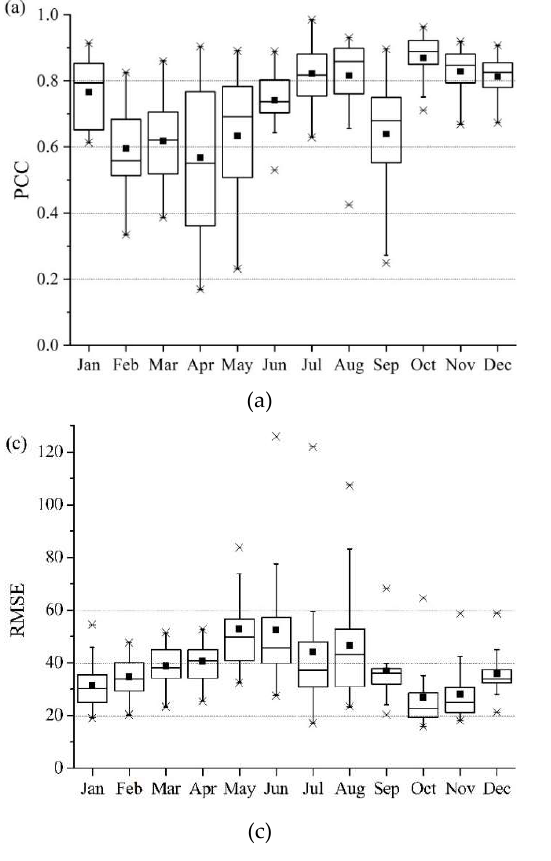
Figure 4. Box diagrams of the four statistical performance indices for RX5day at a monthly scale from 1998 to 2015: (a) PCC; (b) Bias; (c) RMSE; and (d) ME.